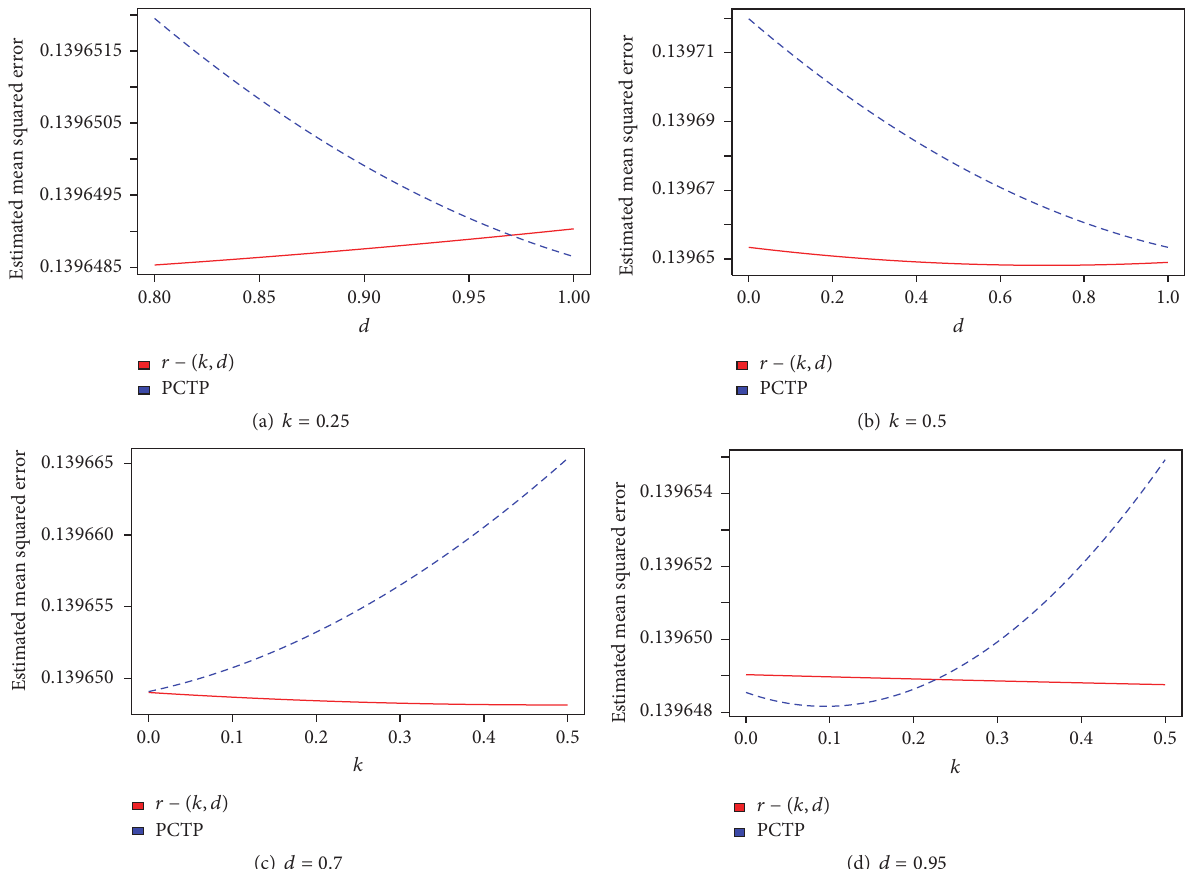
Figure 1: Estimated mean squared error of 𝑟 − (𝑘,𝑑) class and the PCTP estimators for US GDP